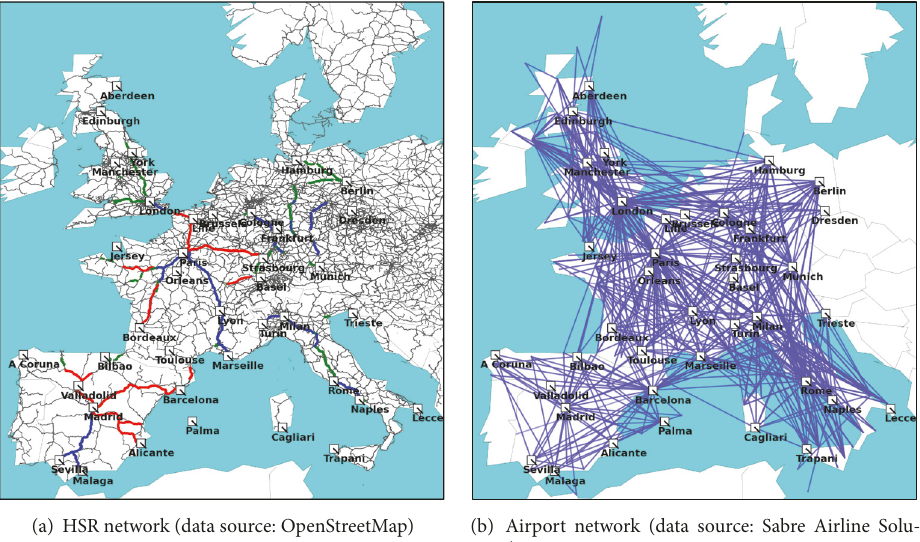
Figure 3: Comparison of HSR networks and airport networks in five European countries (Spain, France, Germany, United Kingdom, and Italy). In the HSR networks, different colors indicate different maximum speed: green color > 200 km/h; blue color > 250 km/h; red color > 300 km/h. In the airport networks, domestic flights with passengers more than 1,000 per month and with distances less than 1,000km are shown. It can be seen that highly developed air transport networks are still denser than newly emerged HSR